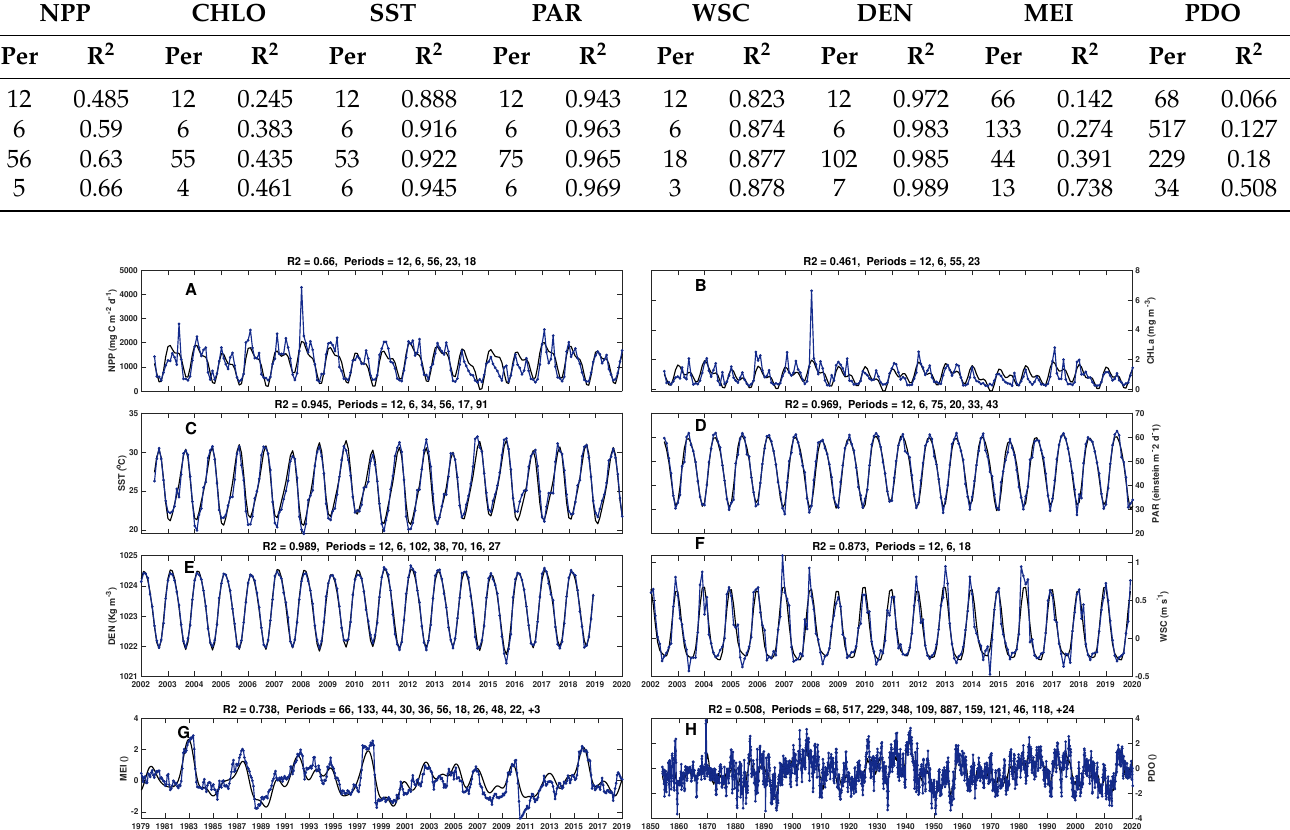
Figure 4. Interannual variation of ( A ) net primary productivity (NPP), ( B ) Chlorophyll a (Chl-a) at the surface ( C ) sea surface temperature (SST), ( D ) photosynthetically available radiation (PAR), ( E ) Density (DEN), ( F ) wind stress curl (WSC), ( G ) multivariate El Niño/Southern Oscillation Index (MEI), and ( H ) Pacific Decadal Oscillation (PDO). The blue line represents the data and the black line shows the resulting harmonic model after applying the cyclical descent technique. ( A – D ) July 2019, and ( H ) January 1854 to December